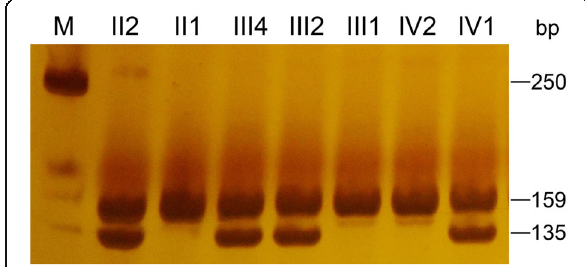
Fig. 4 Polyacrylamide gel electrophoresis confirmed that the nucleotide substitution c.35G > T co-segregated with the disease phenotype in the family. The variant was observed in the proband and her affected mother, aunt, and grandmother, but not in her unaffected father, sister, grandfather or 100 unrelated Chinese controls. The PCR product was 159 bp in length and contained a Sac 1 site. The mutant allele contains a Sac 1 restriction site and can be digested into two fragments (135 bp, 24 bp) by Sac 1, but the wild-type allele cannot be digested. Affected individuals show two bands (135 bp and an undigested band of 159 bp) on an 8% polyacrylamide gel. All the unaffected members show only a